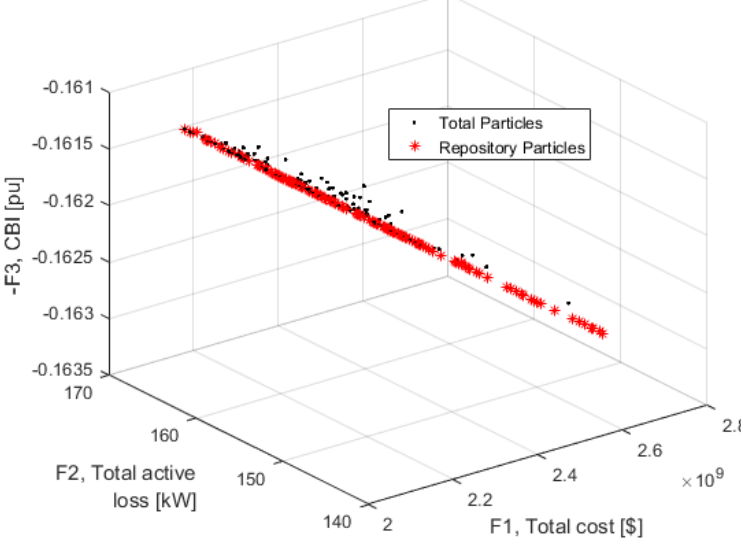
Figure 9. Pareto optimality (Scenario